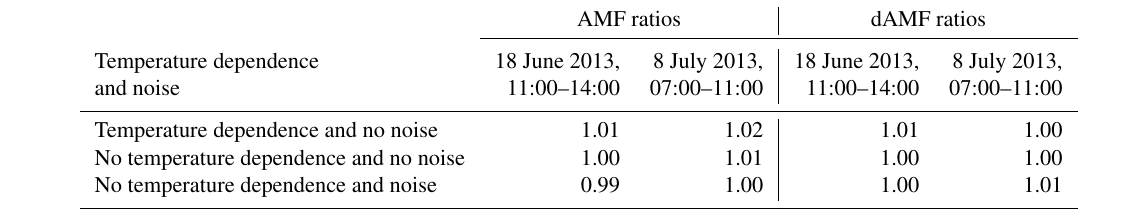
Table A13. Average ratios of O 4 (d)AMFs derived from synthetic spectra vs. those obtained from radiative transfer simulations at 360nm for the middle period on each selected day.